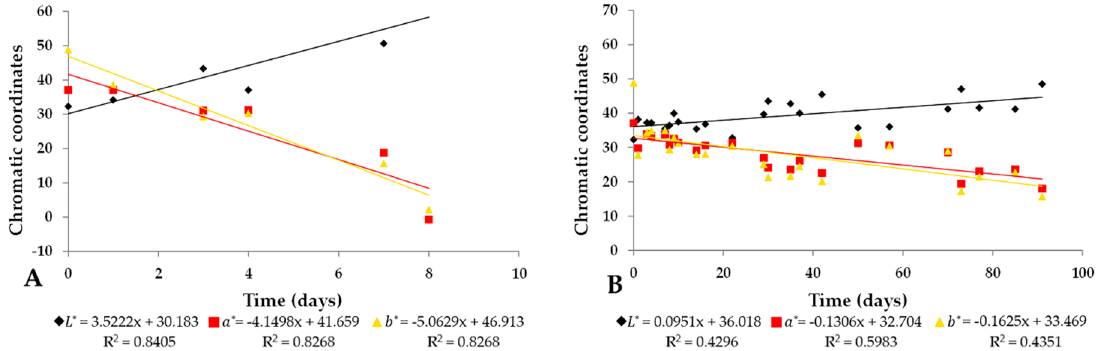
Figure 5. Variation in chromatic coordinates and qualitative characteristics over time. ( A ) PIBP storage under light stress and ( B ) PIBP storage in darkness. R 2 : linear behavior.